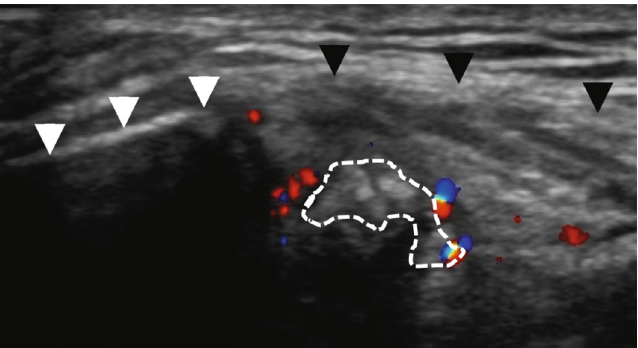
Figure 2: Color Doppler sonogram showing fragmented calci fi cation (dotted line) with hypervascularity, the anterior acromion (white arrowheads), and the deltoid (black arrowheads).